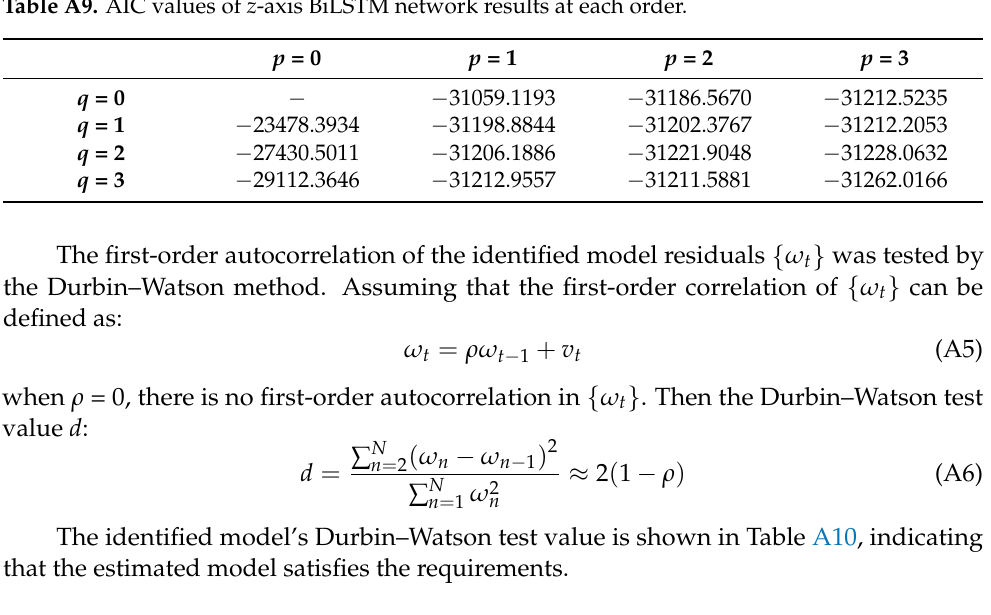
Table A10. D-W test